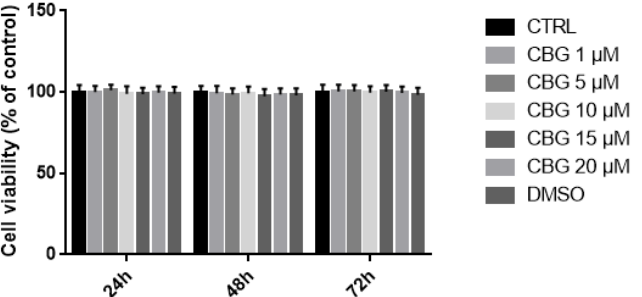
Figure 2. Evaluation of possible effects of CBG at concentrations of 1, 5, 10, 15, and 20 µM, and DMSO on NSC-34 cells viability at 24 h, 48 h, and 72 h. No significant difference in cell viability was detected.